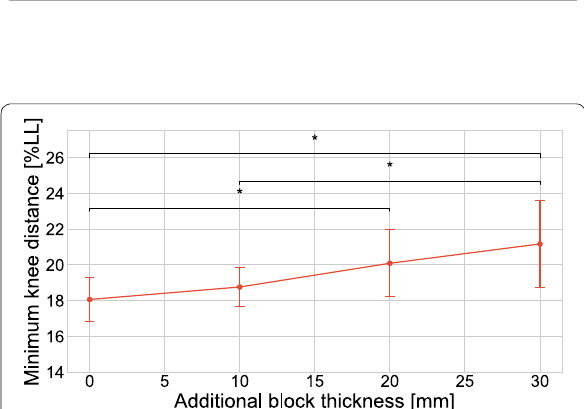
Fig. 8 Minimum distance between both knees and additional block thickness. When the block thickness increased, the minimum distance decreased. This single star (*) represents significant difference of the paired t-test ( P < 0.05 ). These error bars represent standard deviation of means dominated by inter-participant variability